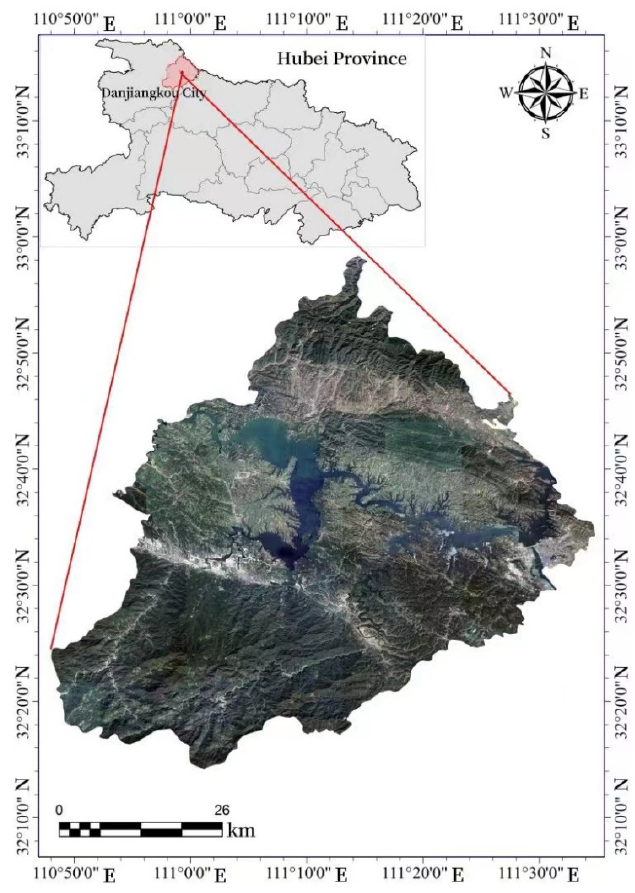
Figure 1. Location of the study